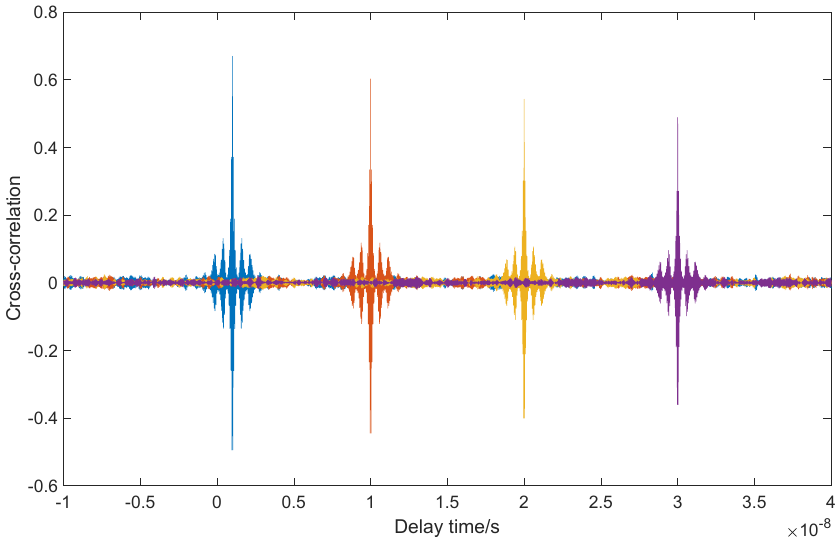
Figure 13. Cross-correlation of chaotic signals with different time delays.